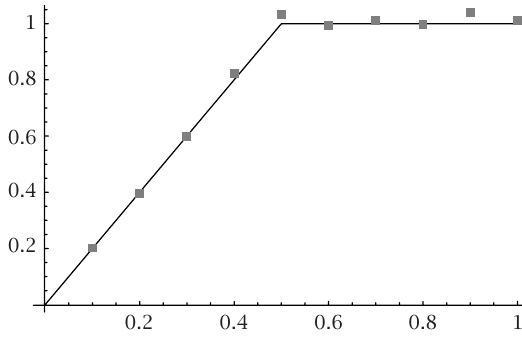
Figure 4.1. Exact and estimated solution for g ( t